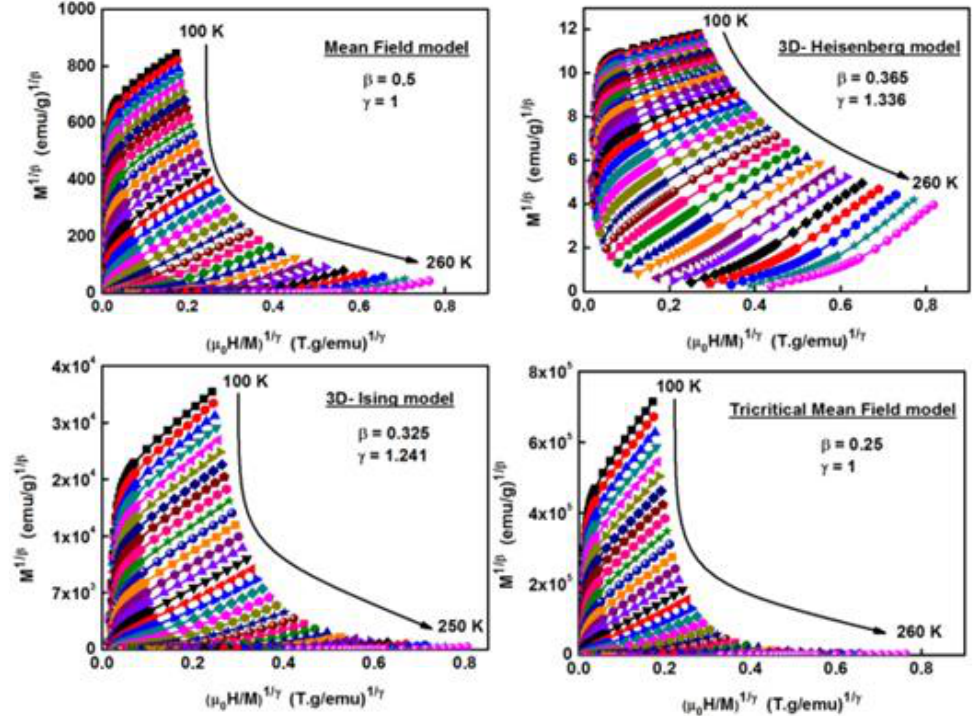
Figure 7. Modified Arrott plots: isotherms of M 1/ β vs . ( H / M ) 1/ γ with the mean field model, 3D-Heisenberg model, 3D-Ising model and tricritical mean field model. From 100 to 260 K (increments of 5 K).